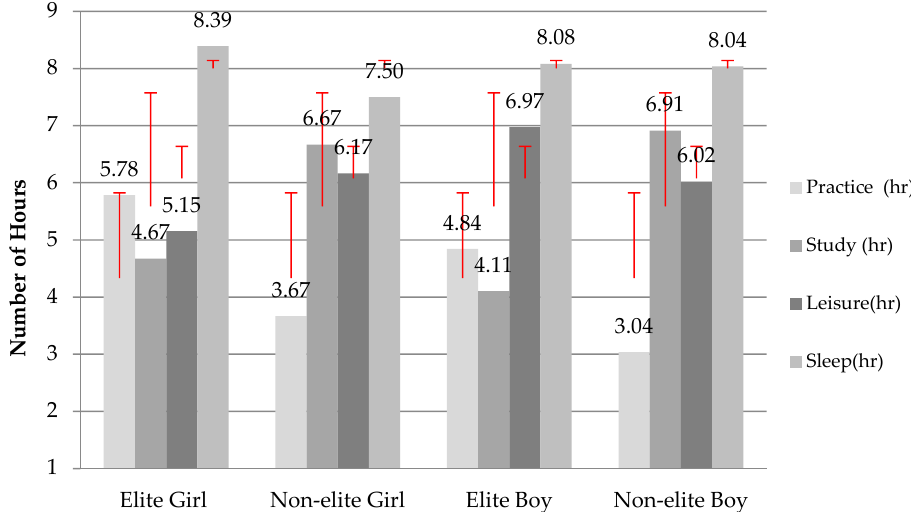
Figure 2. Daily activity pattern, including practice, study, leisure, and sleep hours in elite and non-elite athletes. Figure legend: Error bar shows the standard deviation (practice hr ± 1.22, study hr ± 1.41, leisure hr ± 0.75, sleep hr ± 0.37).